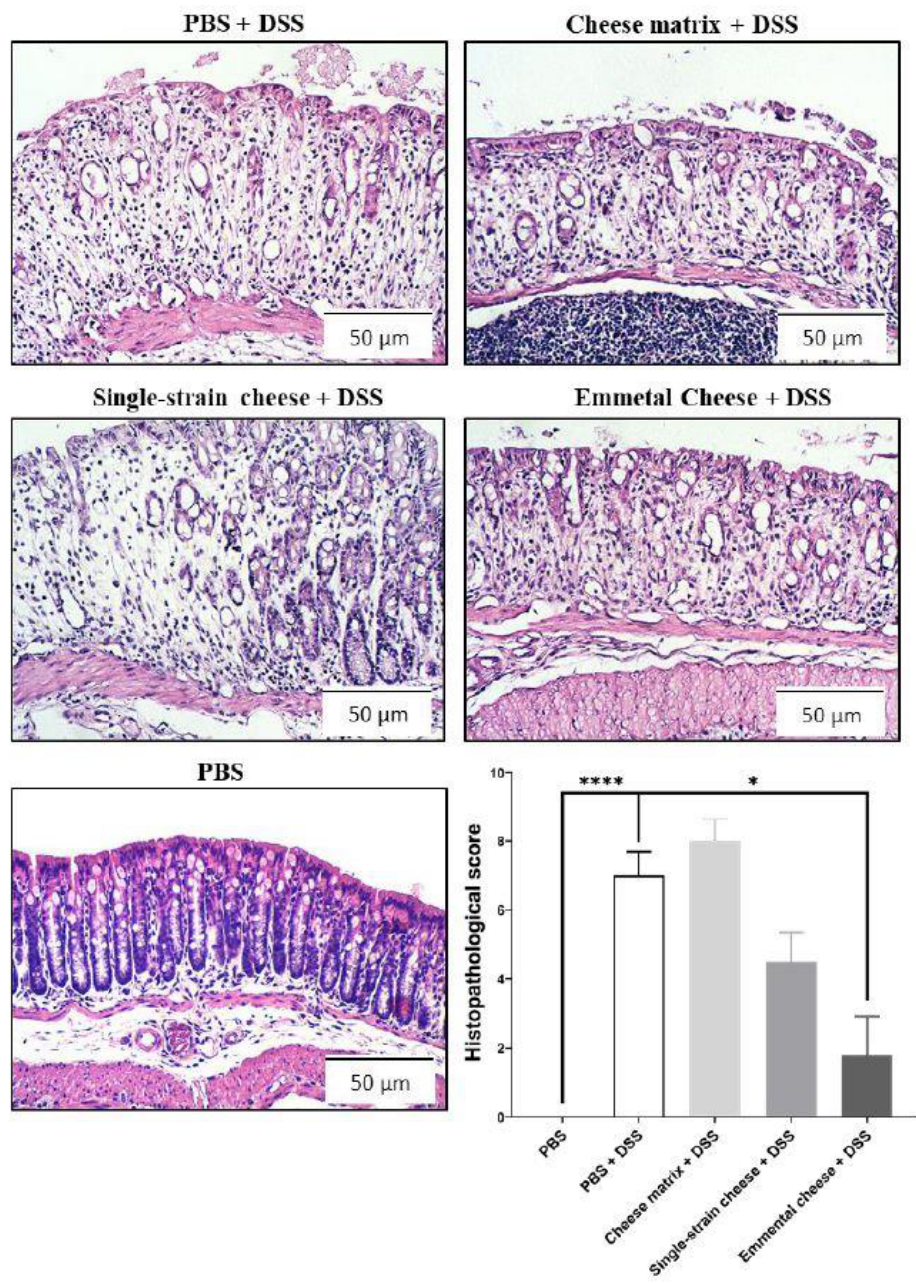
Figure 4. Impact of cheese matrix, single-strain cheese and Emmental cheese on DSS-induced histopathological damages. Representative images of mice colon mucosa sections, stained with haematoxylin, are shown. Image acquisition phase was done with a 20 × magnification objective. Scale bar = 50 µ m. Histopathological scores were determined. Groups were as follows. PBS: healthy group gavaged using PBS bu ff er as a sham. PBS-DSS: DSS-treated-colitis control group gavaged using PBS bu ff er as a sham. Cheese matrix-DSS: DSS-treated group gavaged using a germ-free dairy matrix. Single-strain cheese-DSS: DSS-treated group gavaged using an experimental single-strain cheese containing P. freudenreichii CIRM-BIA 129 as a sole bacterium. Emmental-DSS: DSS-treated group gavaged using an industrial Emmental cheese produced using P. freudenreichii CIRM-BIA 129 as a ripening starter. The data represent the mean ± SD of 6 mice per group. Multiple comparisons were performed, * p < 0.05, ** p < 0.01, *** p < 0.001 **** p < 0.0001.